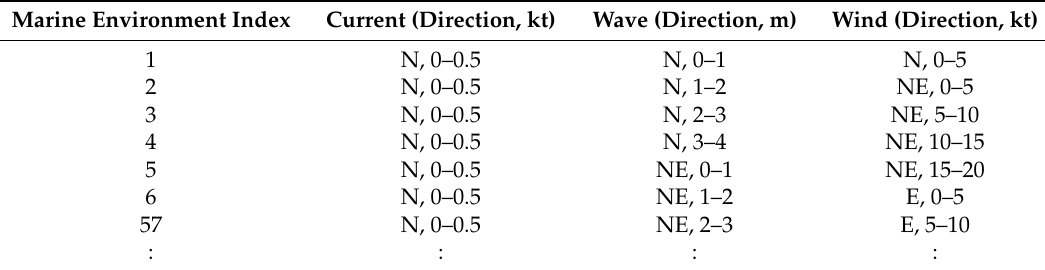
Table 3. Example of marine environment